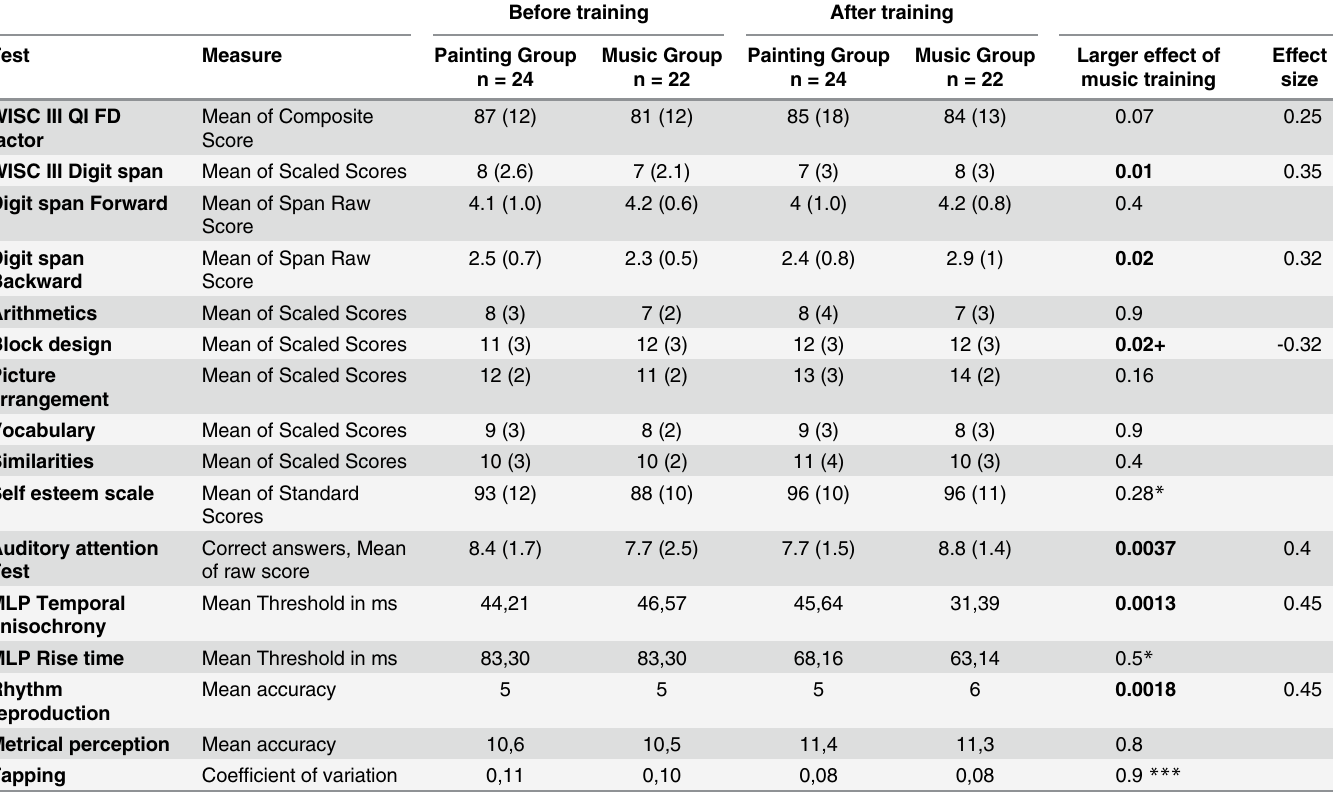
Table 3. Summary of results before and after training in WISC III Subtests, Auditory attention test, Self Esteem Competence Scale and Musical